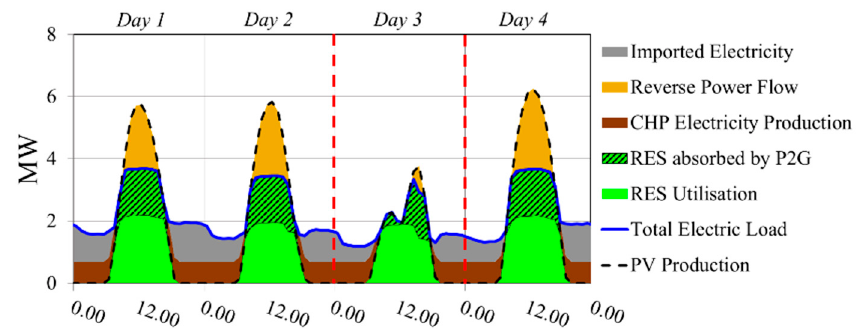
Figure 8. Electricity production share for the case with 1.5 MW P2G. Figure 9. P2G flexibility evolution. Details of Day 3.